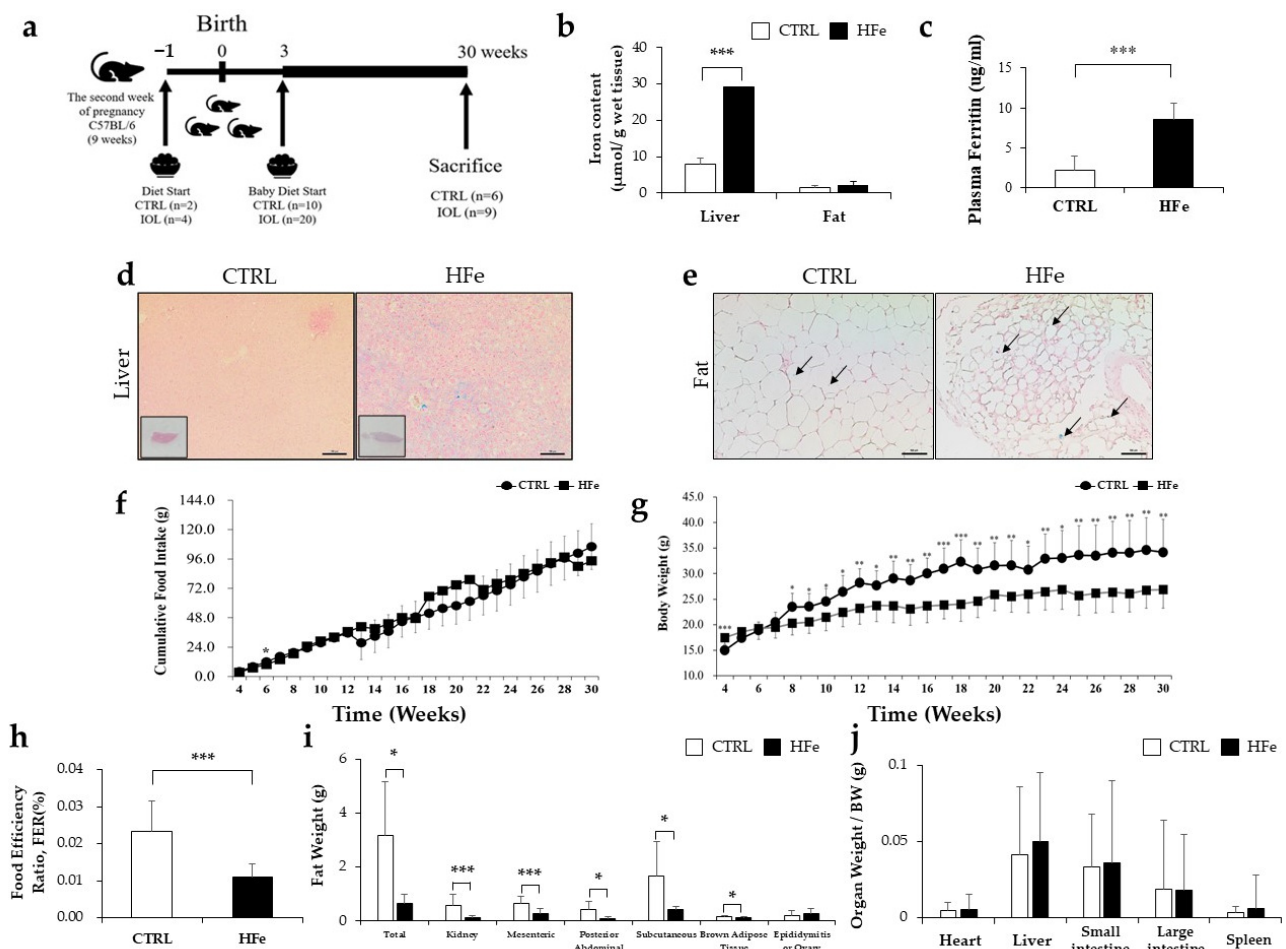
Figure 1. Excessive dietary iron intake decreased body weight and fat mass. Diagram for feeding schedule ( a ) and amount of iron in liver and fat as measured by ( b ) ferrozine assay, plasma ferritin level ( c ), Prussian Blue Staining in the ( d ) liver and ( e ) mesenteric fat. ( f ) Cumulative food intake, ( g ) body weight, ( h ) food efficiency ratio (FER), ( i ) fat weight, and ( j ) organ weight at final week (week 30) of each group (CTRL, HFe). Data are expressed as means ± SE; Student’s t test was used for the test of difference. * p < 0.05, ** p < 0.01, *** p < 0.001. All sections were paraffin embedded. Scale bar, 100 μ m; magnification, ×10. Black arrows show blue stain indicating iron accumulation in each tissue.